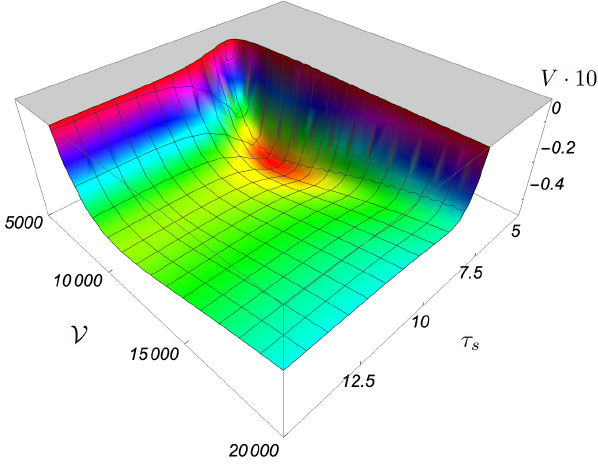
Figure 2 . New AdS minimum from ( α 0 ) 1 loop effects with α > 0 and parameters given by